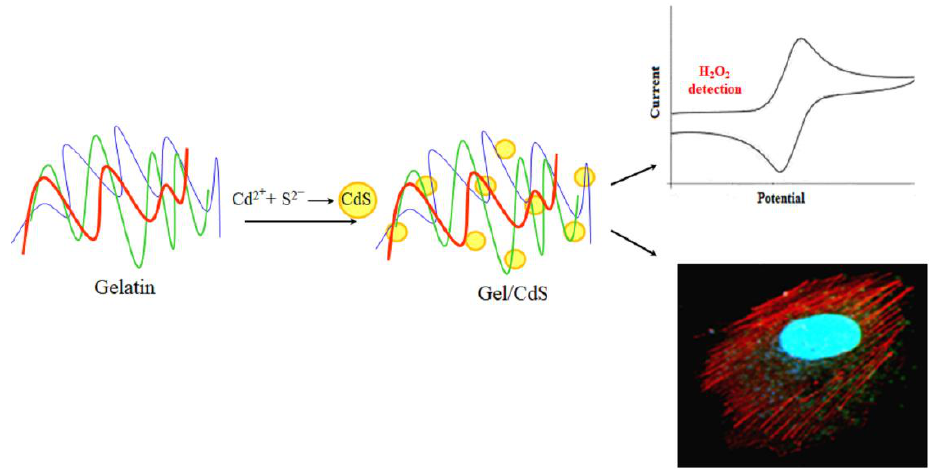
Figure 1. Biomimetic synthesis of cadmium sulfide (CdS) QDs in a biopolymer gelatin template as a system for biosensor and cellular imaging applications.